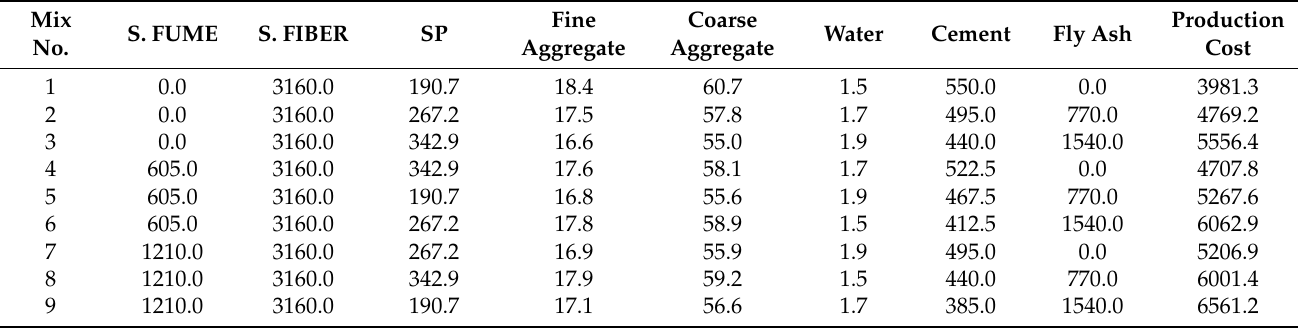
Table 2. Predicted cost for all mixes (LE/m 3 ).